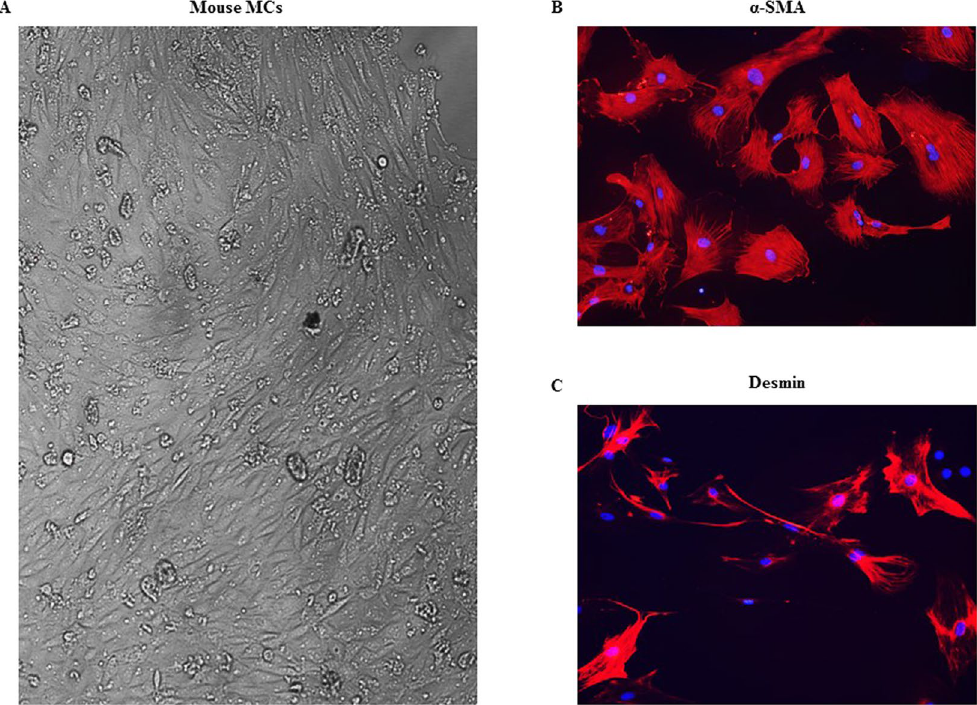
Figure 5. Identification of mouse MCs. ( A ) Monolayer of spindle shaped MCs. ( B ) Staining MCs for α -smooth muscle actin (red). ( C ) Staining MCs for desmin (red). In both B and C, cell nuclei were stained with DAPI (blue). Magnification: ×